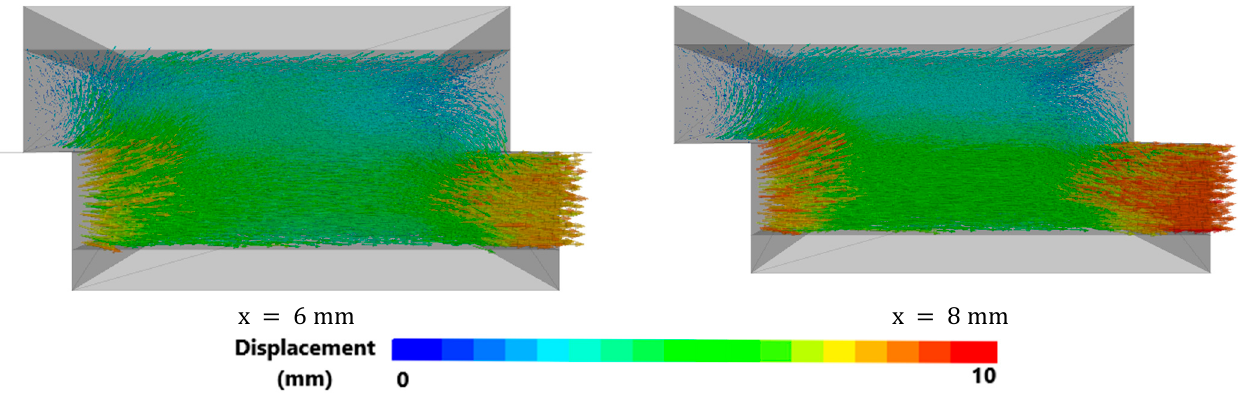
Figure 7. Displacement vectors of particles drawn at the same scale for sample sheared under σ n = 160 kPa to a displacement of x = 8 mm .